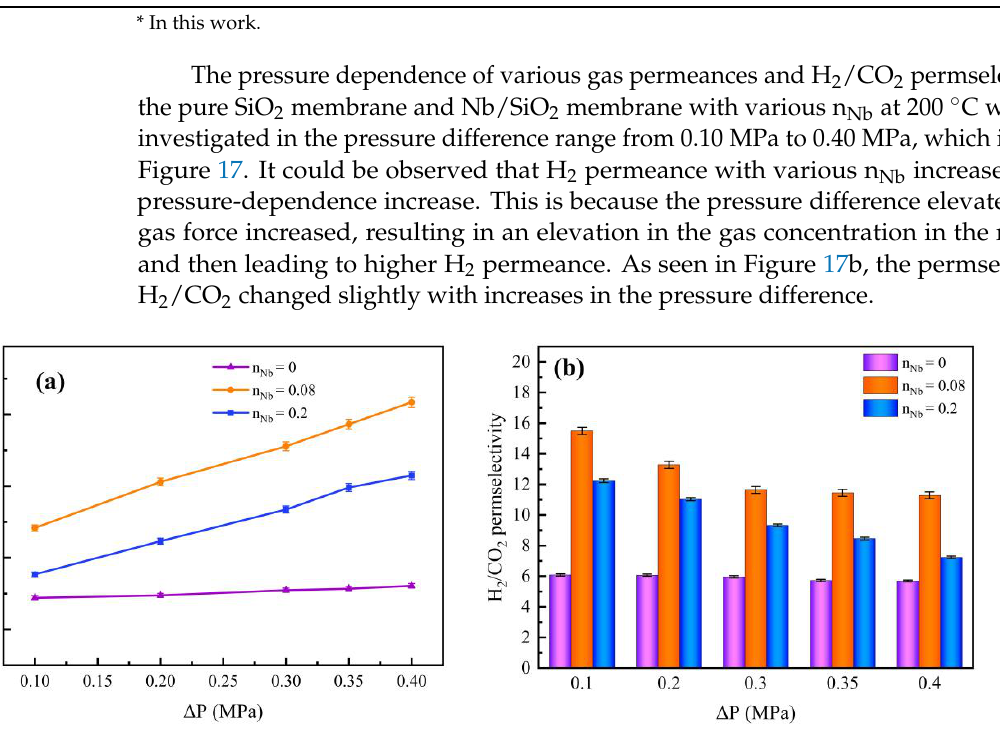
Figure 18. Effect of pressure difference on ( a ) gas permeances and ( b ) H 2 permselectivities of Nb/SiO 2 membrane at 200 °C. Traditional SiO 2 membranes have poor hydrothermal stability due to a large amount of Si-OH groups on their surfaces, which easily absorb water vapor in the air. In the Nb/SiO 2 membrane, not only the Nb-doping but also the introduced hydrophobic groups can improve the vapor stability, which can reduce the hydroxyl groups on the pore sur- face and enhance the hydrophobicity. In order to test the hydrothermal stability of membranes, the Nb/SiO 2 membranes with n Nb = 0 and 0.08 were chosen to investigate the gas permeance before and after steam treatment.